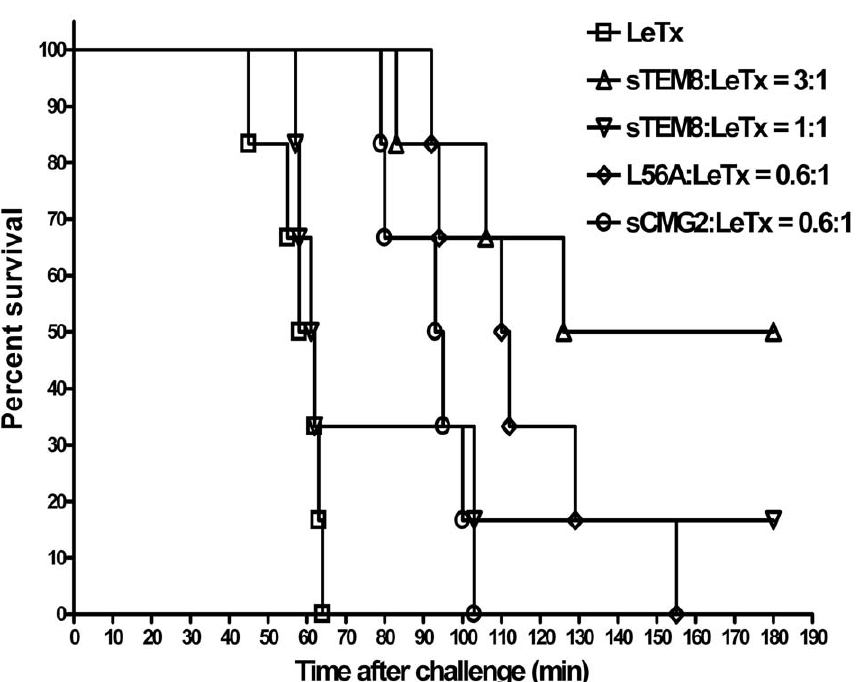
Figure 2. Receptor variants protect Rats from LeTx intoxication. Survival curves of rats protected by receptor decoys at different doses after anthrax lethal toxin attack. Ratios indicate the receptor/decoy: PA ratio when the former was mixed with lethal toxin (LeTx). Rats were monitored for 3 h after i.v. administration and then overnight. For convenient comparison, groups with full protection are not shown and are listed in Table 2.